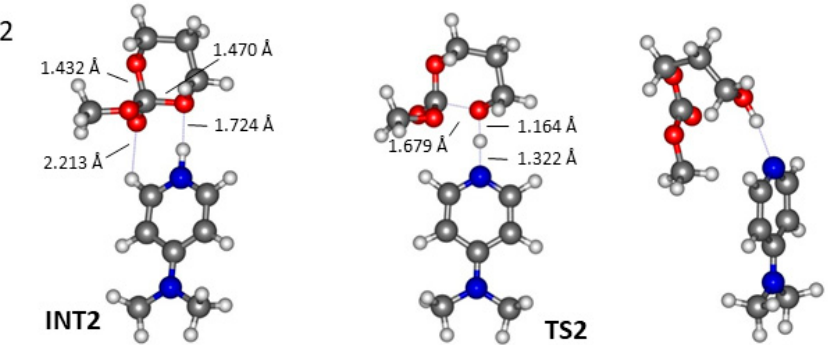
Figure 4. Optimized geometry structures of the species involved in the second step of the H-bond/alcohol activation mechanism of the DMAP-catalysed ring-opening polymerization of TMC. Colour code: C grey, O red, N blue and H white.